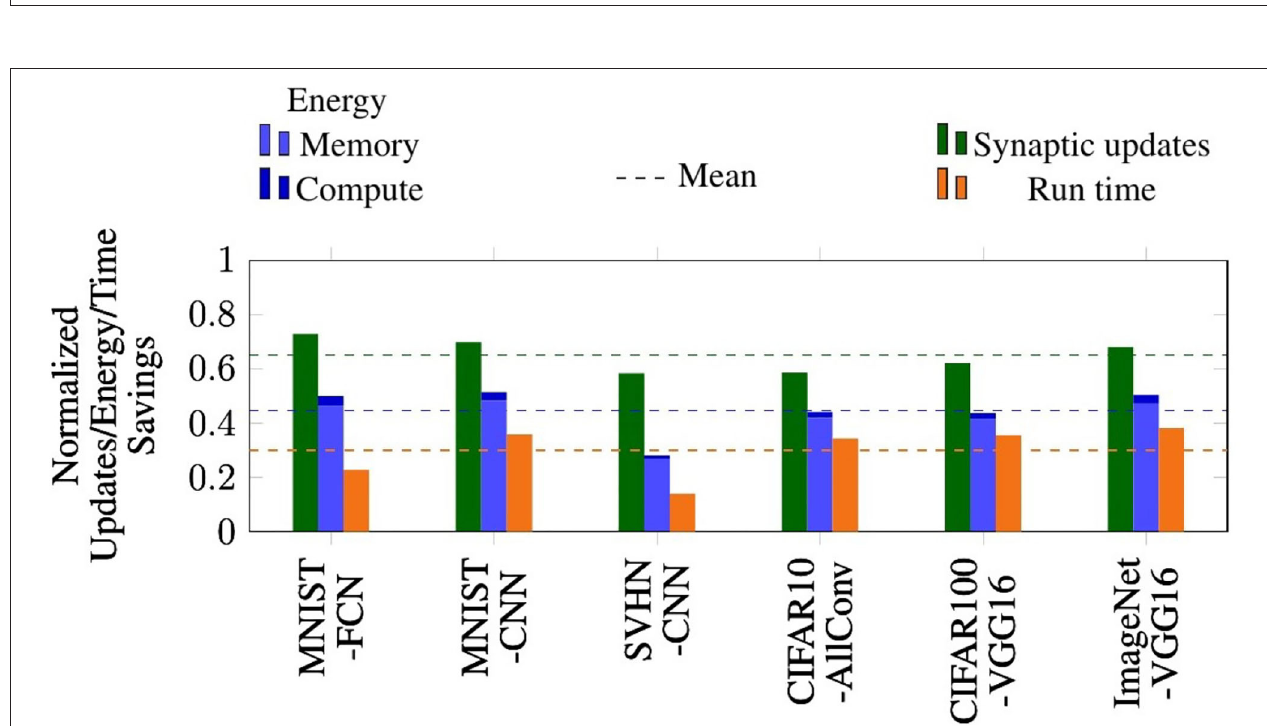
FIGURE 12 | Performance benefits of probabilistic spike propagation on P-SNNAP.